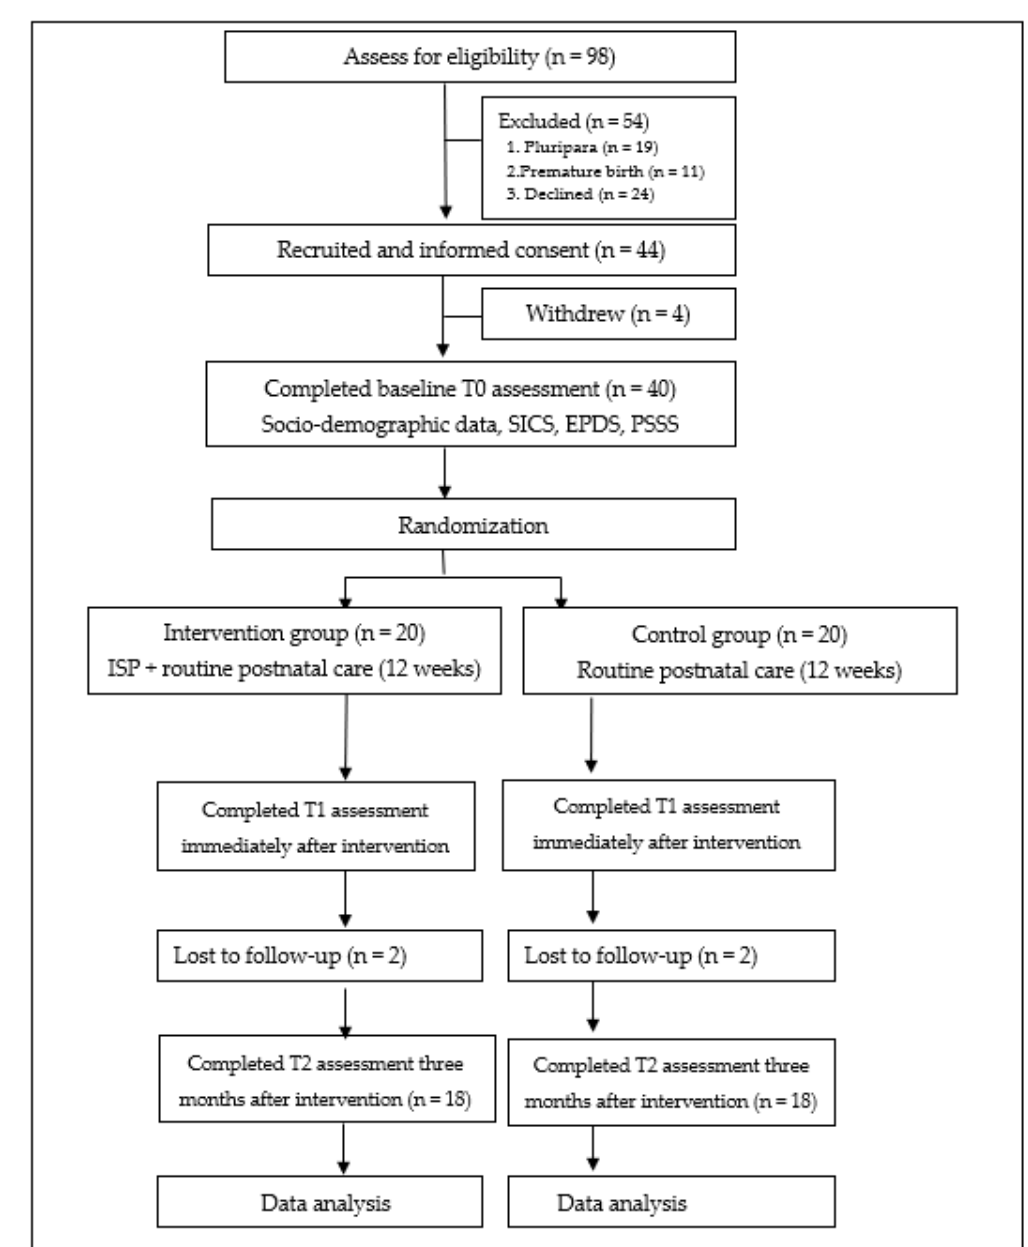
Figure 1. CONSORT (Consolidated Standard of Reporting Trials) flowchart of the Internet-based Support Program (ISP). SICS: the Self-efficacy in Infant Care Scale; EPDS: the Edinburgh Postnatal Depression Scale; PSSS: the Postpartum Social Support Scale.